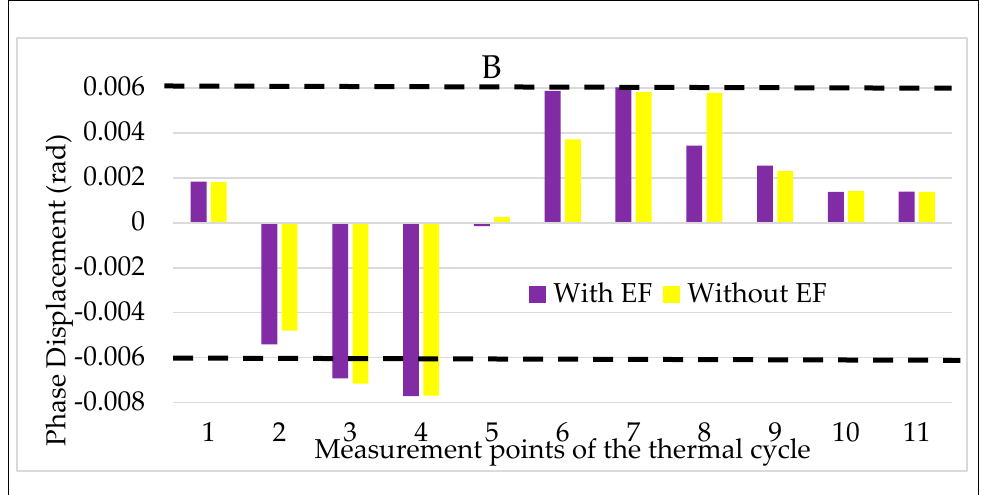
Figure 15. Ratio error vs. temperature + electric field for LPVT B.